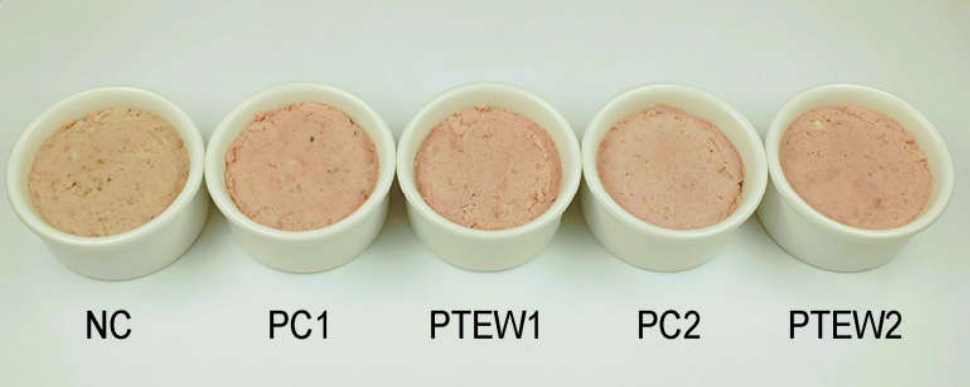
Figure 2. Pork liver pâtés in porcelain bowls—top view; from the left: NC—negative control (liver pâtés without nitrite source); PC1—positive control (liver pâtés with 60 ppm of sodium nitrite); PTEW1—liver pâtés with plasma-treated egg white containing 40 NO 2− ; PC2—(liver pâtés with 120 ppm of sodium nitrite); PTEW2—liver pâtés with plasma-treated egg white containing 80 NO 2− . Table 4. The effect of plasma-treated egg whites on color parameters (mean ± SE 1 ) of liver pâtés Table 5. The effect of plasma-treated egg white on TBARS values (mean ± SE 1 ) of liver p â t é s during storage. Parameters Group